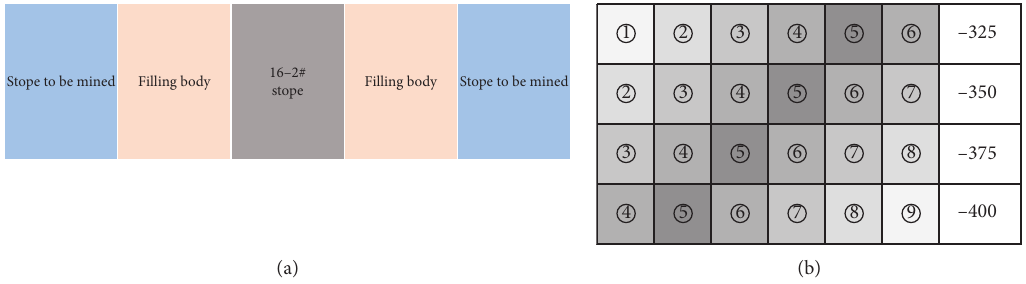
Figure 10: Schematic diagram of stope mining sequence. (a) Layout along the ore body strike. (b) Vertical ore body strike layout.